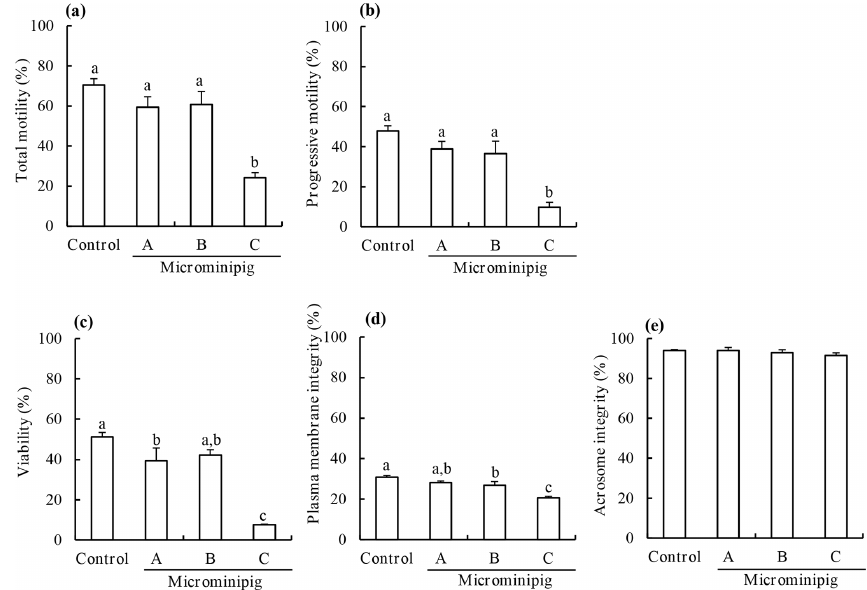
Figure 1. The total motility (a) , progressive motility (b) , viability (c) , plasma membrane integrity (d) , and acrosomal integrity (e) of frozen– thawed spermatozoa collected from three microminipig boars. As a control, spermatozoa were collected from a Large White boar. Data are presented as mean ± standard error of mean in four replicate experiments, using the same batch of each boar. (a–c) Bars with different letters differ significantly ( P< 0 . 05). Table 1. Effects of sperm concentration and different boars on the fertilization and development of porcine oocytes fertilized with frozen– thawed spermatozoa from microminipigs.* Boar** Sperm No. No. (%) of oocytes*** No. of No. (%) of embryos**** concentration of examined Fertilized Monospermy examined Cleaved Developed to ( × 10 6 cells/mL) oocytes embryos blastocysts Control 1.0 110 76.1 ± 5.4 a 55.8 ± 6.0 b 240 84.4 ± 1.1 a, c